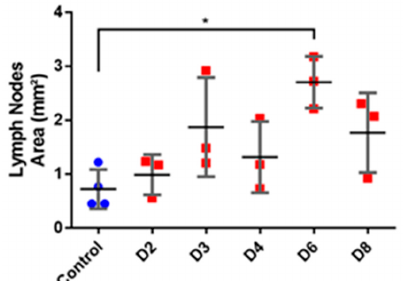
Figure 10. Evaluation of area of lymph nodes (mm 2 ) in the course of IMQ-induced psoriasis-like dermatitis. Evaluations were analyzed using one-way ANOVA followed by Dunnett multiple comparison test. Values are presented as mean ± SD ( n = 3, except for control where n = 4). *: p < 0.05.